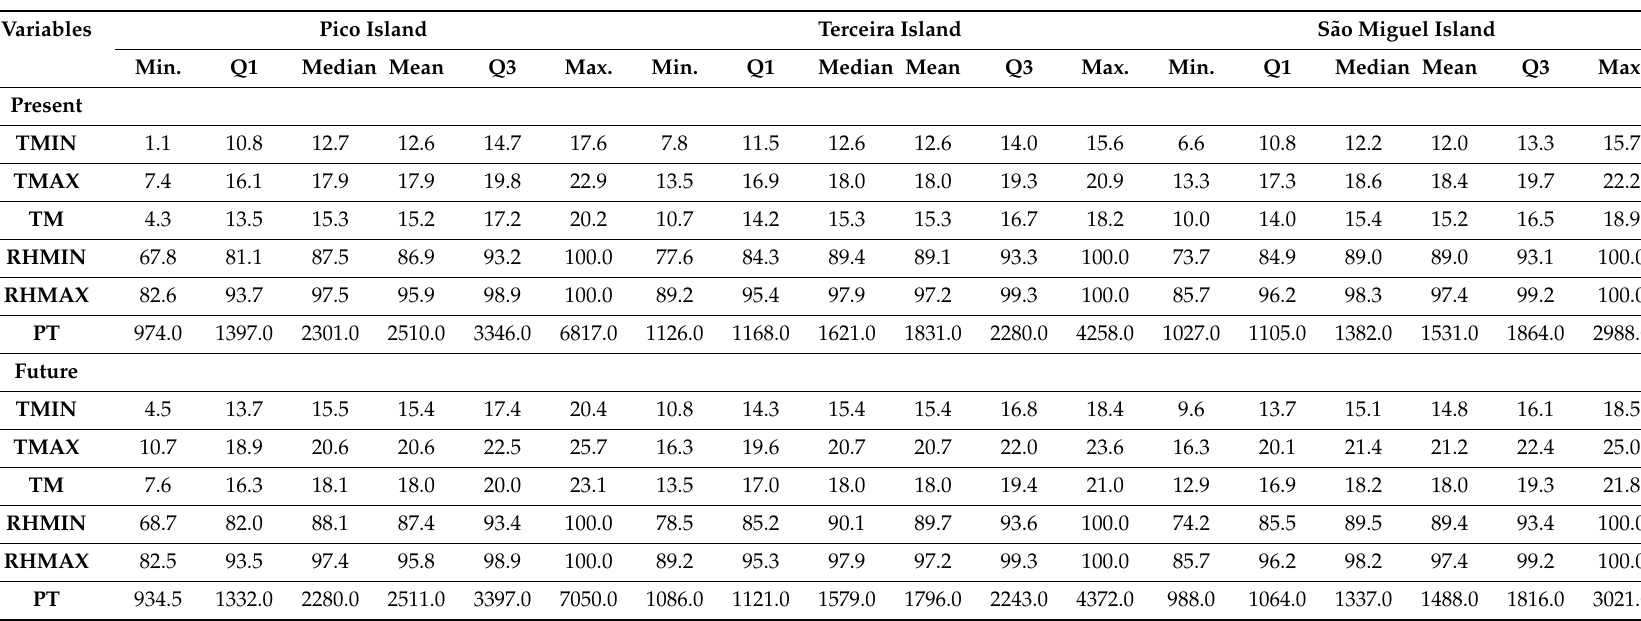
Table 2. Summary of present and future climatic variables for three distinct islands. TMIN: Annual minimum temperature; TMAX: Annual maximum